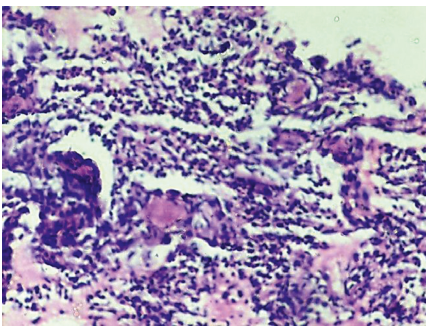
Figure 5: High-power examination shows Masson bodies that are rounded nodules of granulation tissue in alveolar spaces.